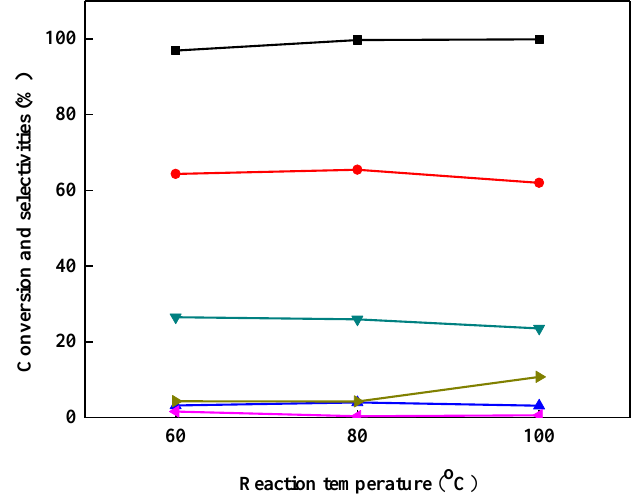
Figure 4. Chlorination of toluene with gaseous Cl 2 over the [BMIM]Cl-2ZnCl 2 ionic liquid catalyst at different reaction temperatures. ■ , conversion of toluene; ●, selectivity of o -chlorotoluene; ▲ ,